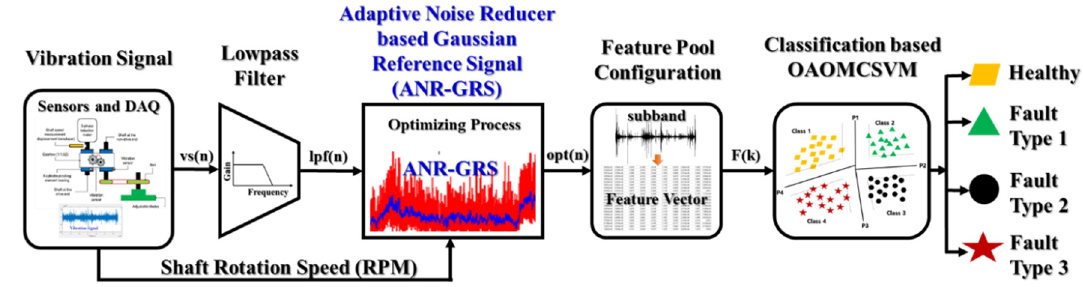
Figure 5. Function block diagram of the proposed methodology.